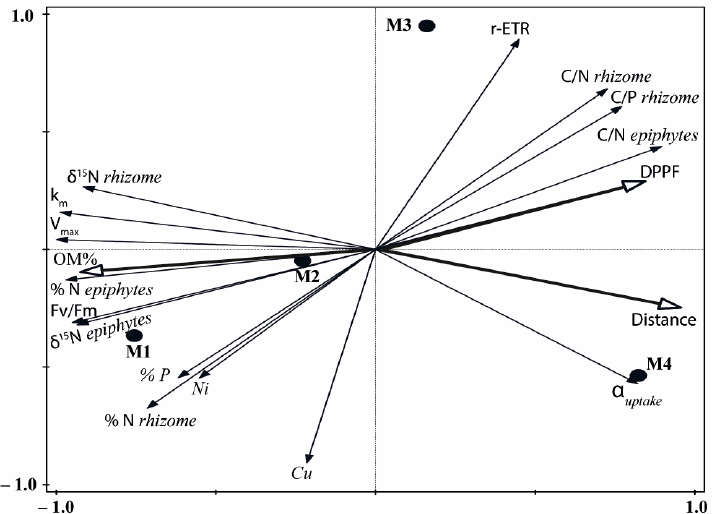
Figure 6. Unconstrained principal components analysis (PCA) of biological indicators of anthro- pogenic pressure from the four studied deep meadow sites (M1–M4). Abiotic factors (DPPF, OM % and distance) are superimposed on the